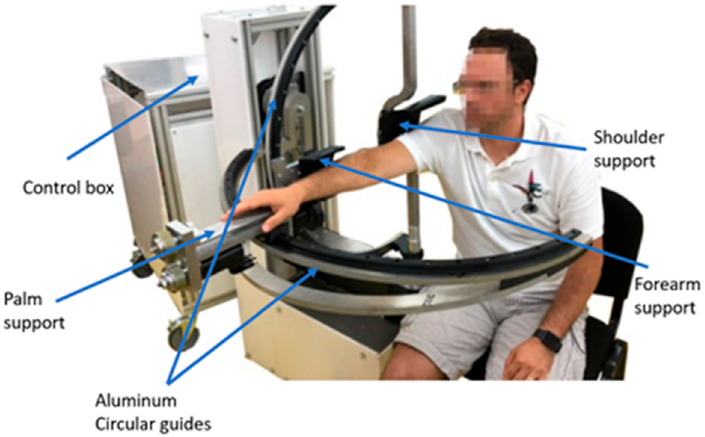
Figure 3. Initial experimental model of ASPIRE.